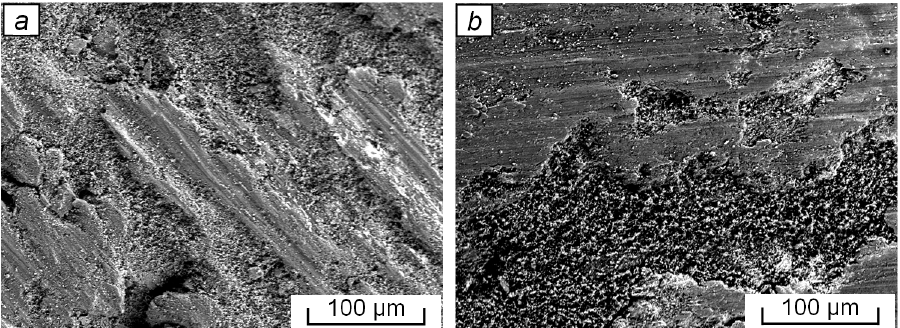
Figure 5. SEM (BSD) images of the friction surface of the Al-30Sn sample. Number of ECAP passes: ( a )—0 (sintered); ( b )—2; P = 1 MPa; V sl = 0.07 m/s; L = 1000 m.